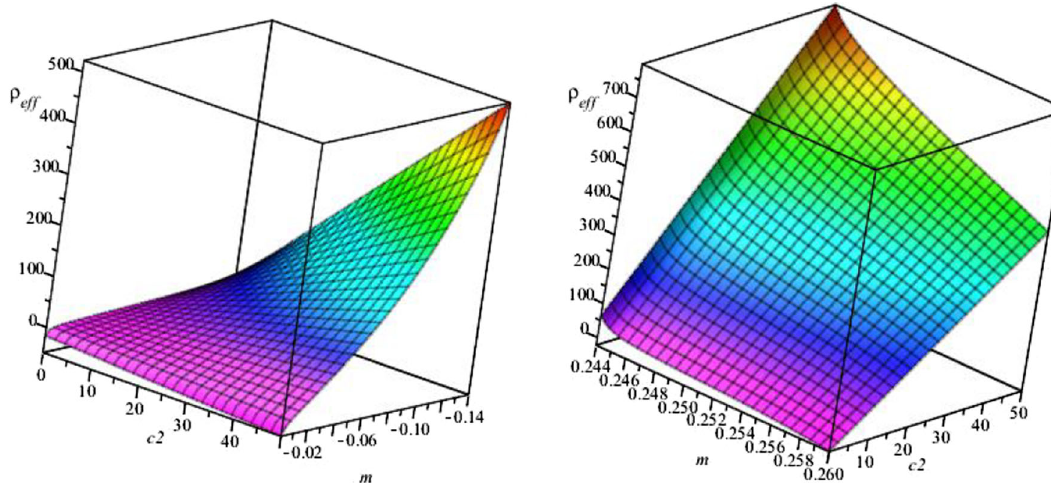
Fig. 1 The allowed range of parameter m for energy conditions